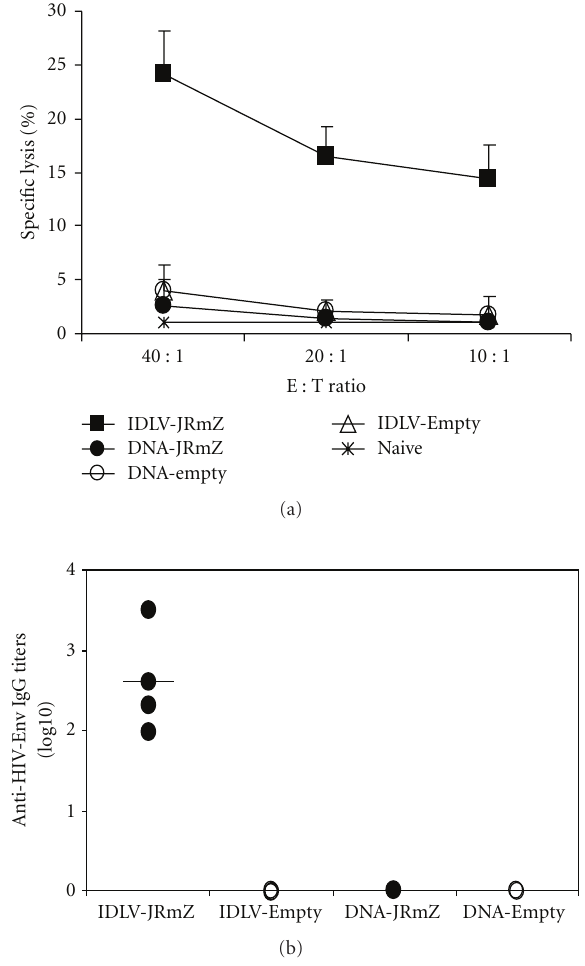
Figure 3: (a) Anti-Env specific CTL activity in mice immunized with IDLV-JRmZ, IDLV-Empty, DNA-JRmZ, and DNA-Empty or in naive mice (four mice/group). Results from one representative experiment out of three independent experiments are shown. 51 Cr-release assay was performed after 4 days in vitro culture, as described in Section 2. The percentage of specific lysis is shown at three di ff erent E : T ratios: 40 : 1, 20 : 1, and 10 : 1. (b) Anti-HIV- Env IgG antibodies measured by ELISA in sera of mice at 90 days after immunization. Sera samples from the immunized mice were analyzed separately. Line represents the geometric median value in the IDLV-JRmZ